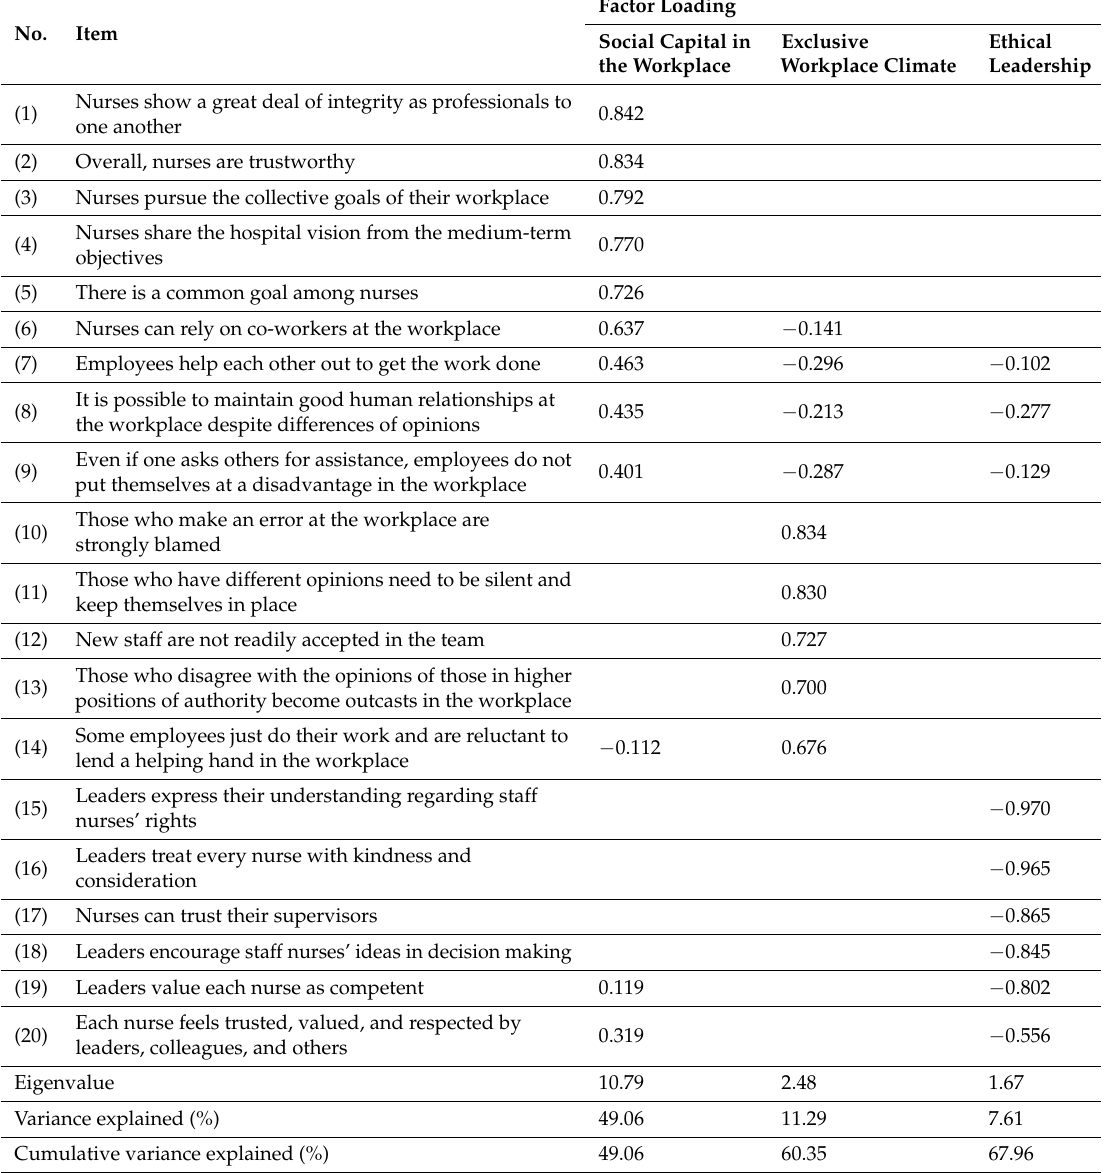
Table A1. The 20-item Social capital and Ethical climate at the Workplace of a hospital (SEW) a